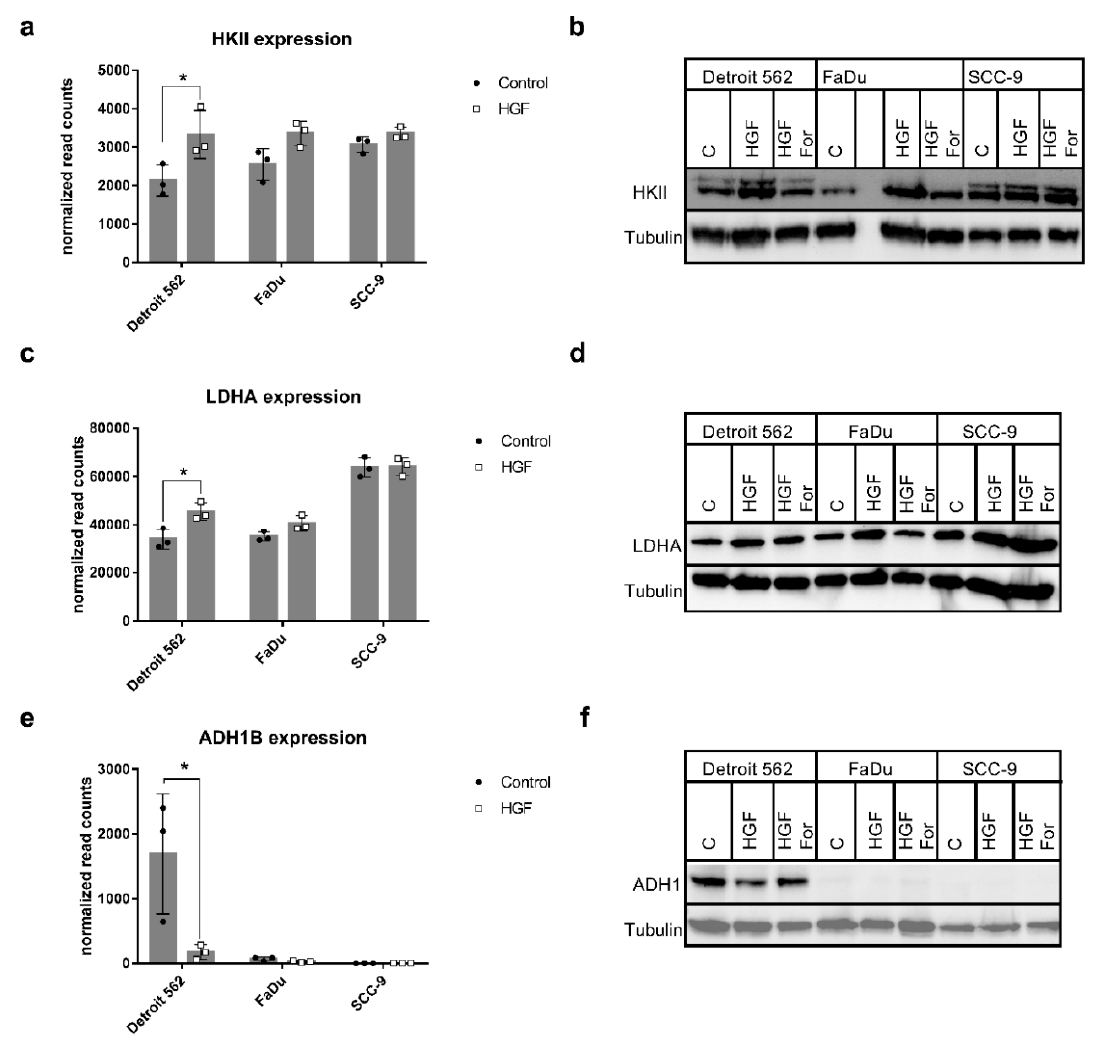
Figure 6. Differential expression of genes participating in glycolysis/gluconeogenesis. ( a , c , e ) Diagrams show normalized gene expression levels resulting from mRNA sequencing for genes HKII ( a ), LDHA ( b ), and ADH1B ( e ). HGF-stimulated samples are shown in grey, untreated controls in black. *: p adj < 0.1. ( b , d , f ) Western blots with lysates of cells stimulated for 48 h (24 h in case of ADH1) with 0.6 nM HGF (HGF), HGF plus 500 nM foretinib (HGF For), or neither (C) for the indicated proteins. Blots were stripped and reprobed with an antibody specific for tubulin to show differences in gel loading. A typical experiment out of three is shown.